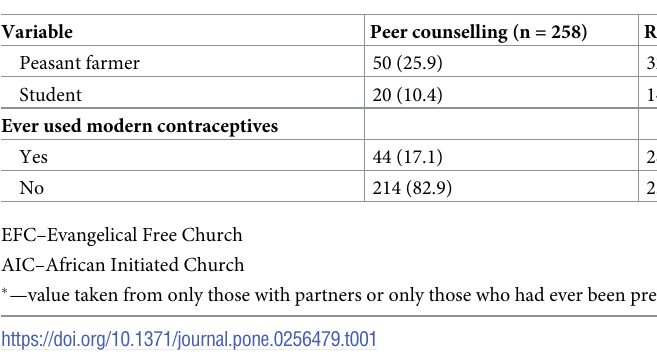
Results relating to the primary and secondary outcomes are presented in Table 2 and presented by study group. The outcomes same day acceptance and reasons for non-acceptance differed between study groups i.e participants who received peer counselling had more acceptors (58.5%) than those who received routine counselling (49.6%). The commonest reason for non- acceptance in the peer counselling group was lack of time contrary to fear of side effects in the routine counselling group. There was no difference in the type of contraceptive method accepted between the two study groups (Table 2).